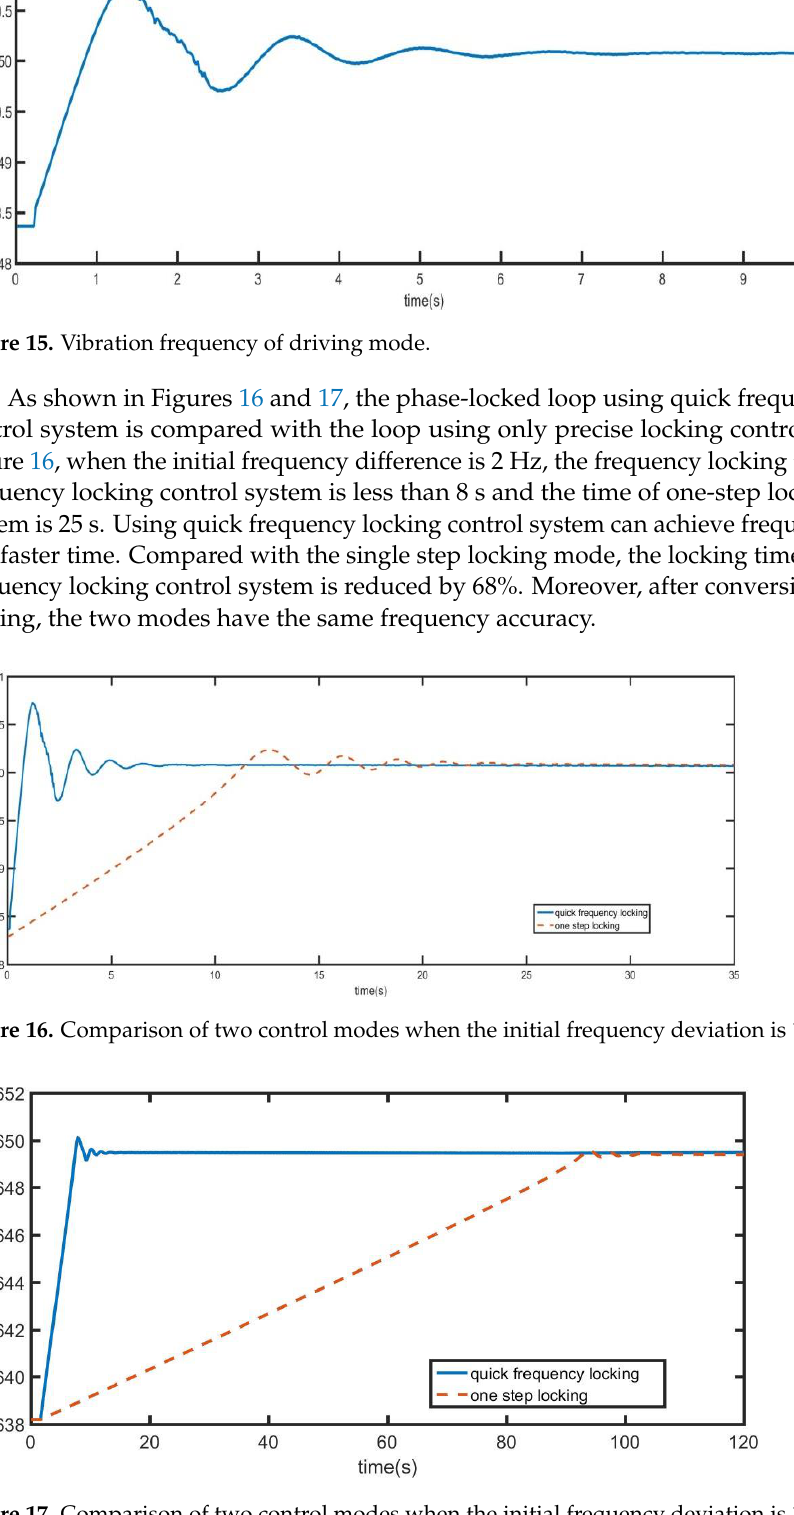
Figure 14. Test platform.